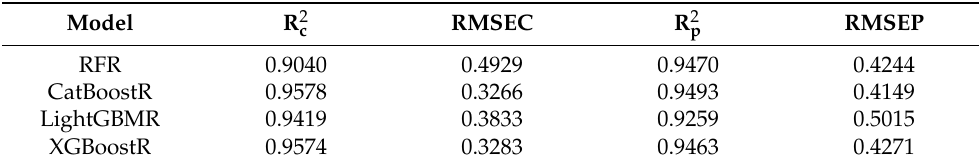
Table 2. Detection results based on different models of full spectrum.